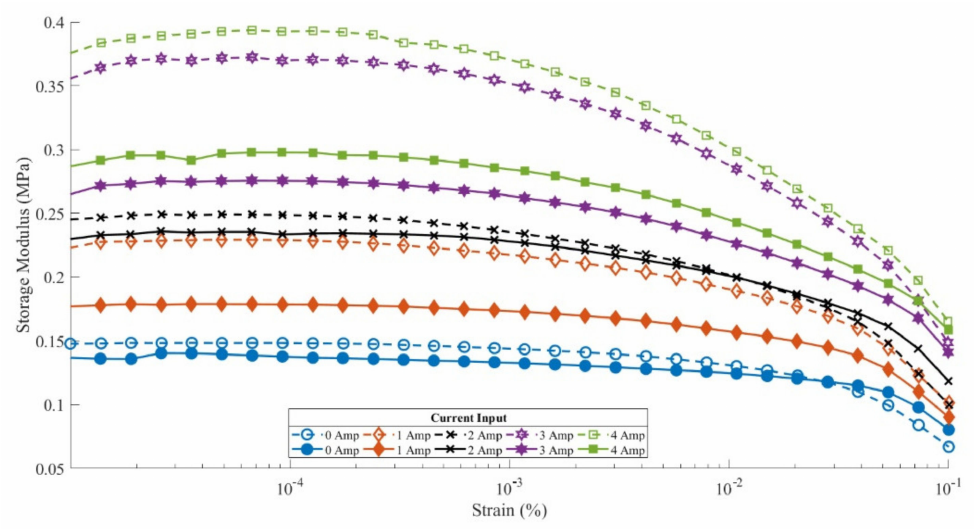
Figure 4. Results of MRE sample rheometer test for anisotropic treated and isotropic